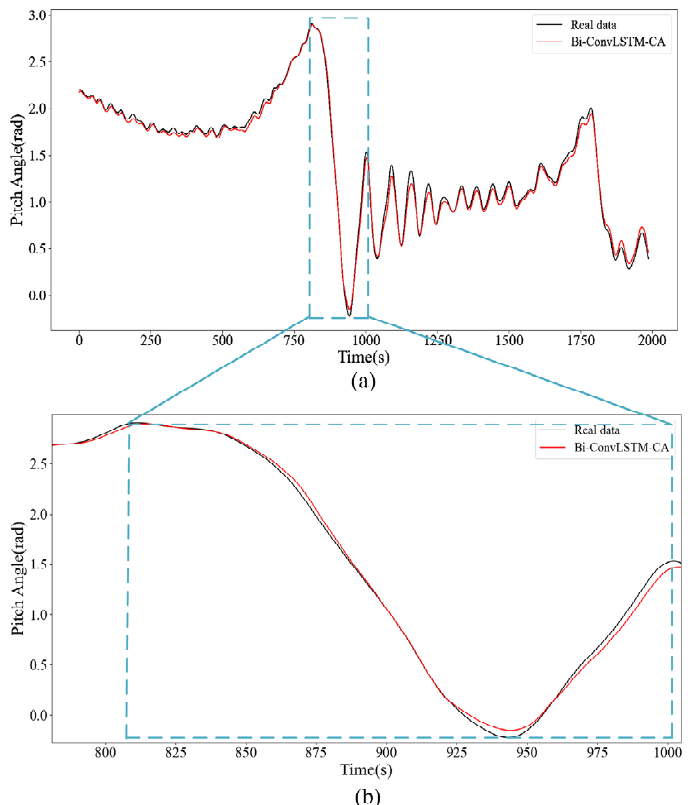
Figure 11. Ship pitch angle prediction results of Bi-ConvLSTM-CA model. ( a ) Ship pitch angle prediction results of Bi-ConvLSTM-CA model in 0–2000 s; ( b ) Ship pitch angle prediction results of Bi-ConvLSTM-CA model in 810–1000 s.